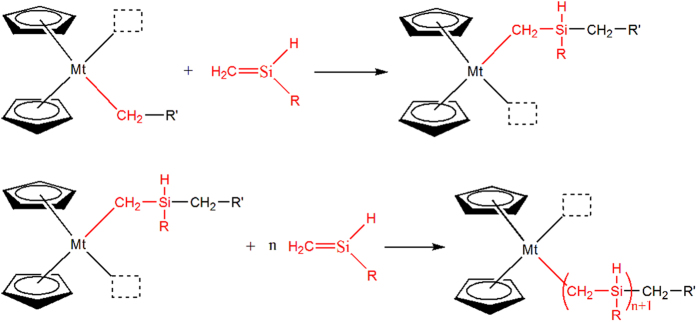
Metallocene catalytic insertion polymerization of 1-silene as analogues of 1-olefins.R = CH3, C2H5, C6H5, etc. R′ = H, Si(CH3)2Cl, Si(CH3)2-Si(CH3)2Cl, etc.